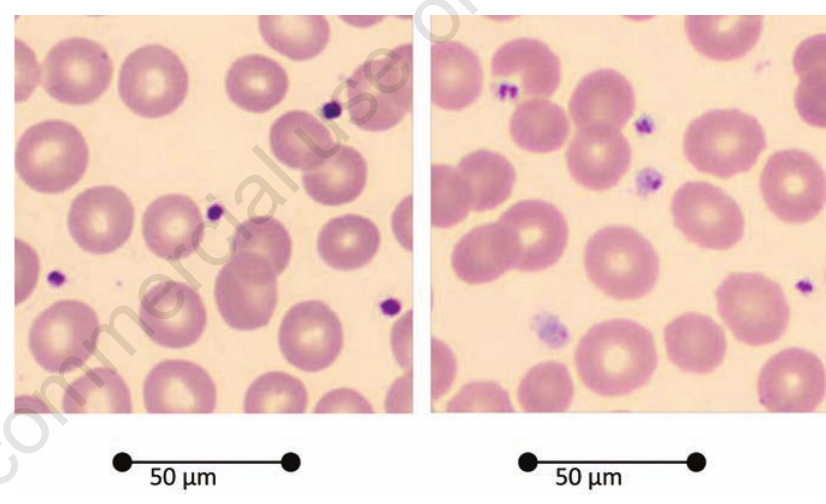
Figure 1. Light microscopic evaluation of PLTs with appropriate (>75%, left) and with decreased (<25%, right) staining density of the granule-containing cytoplasma. Magnification: 600x.